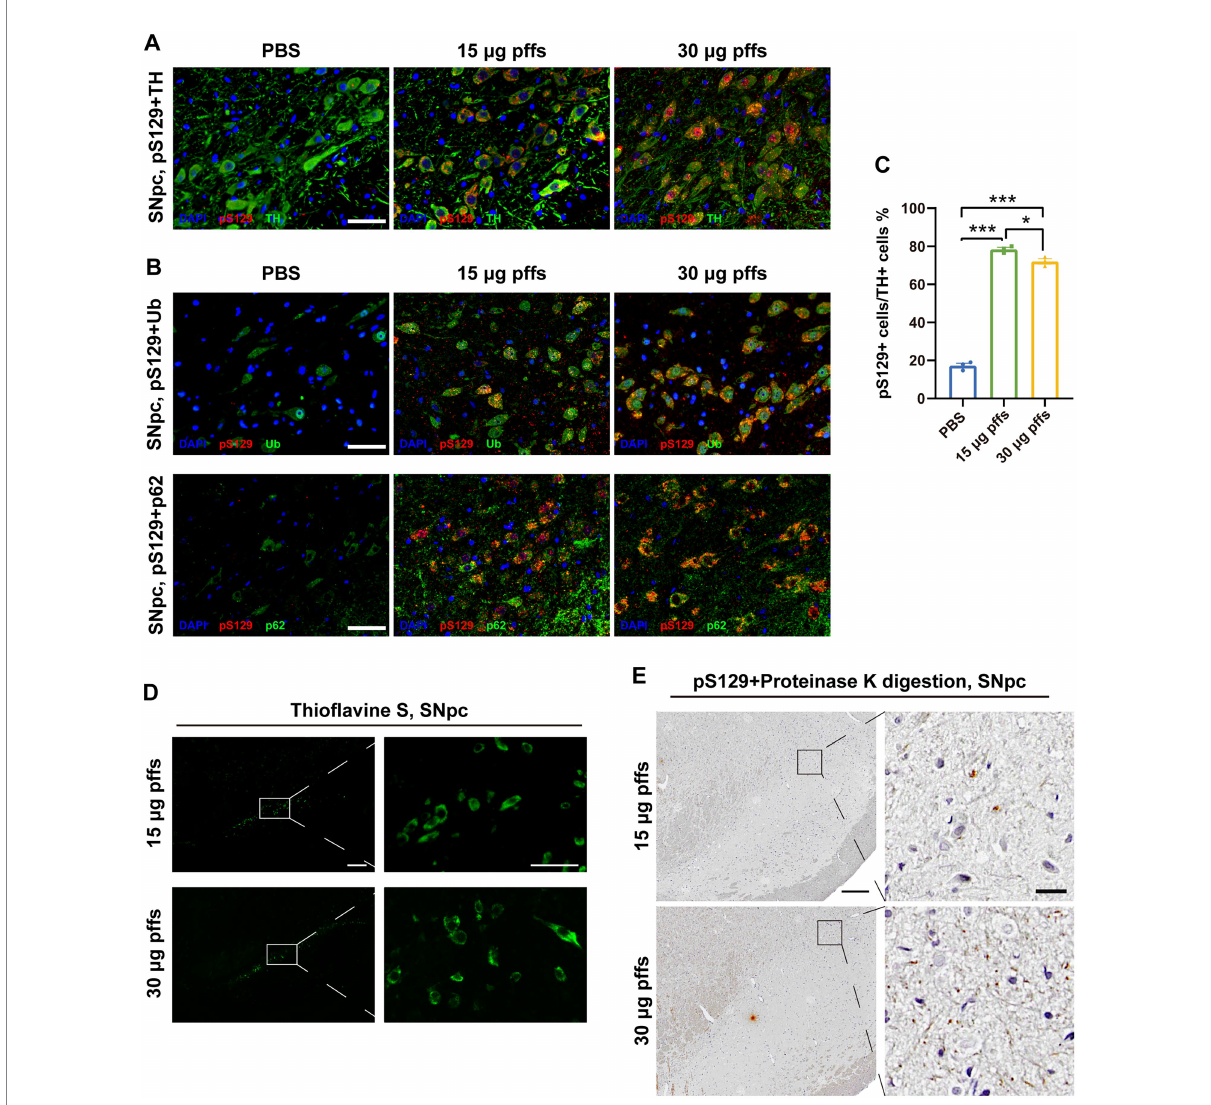
FIGURE 3 Intrastriatal injection of α -SynN103/tauN368 PFFs complex initiated α -synucleinopathy with common characteristics as human conditions in rats. (A) α -Syn pathology was detected in the ipsilateral SNpc. Scale bar = 50 μ m. (B) α -Syn aggregates in the section of SNpc were confirmed by anti- α - Syn pS129, anti-p62 and anti-ubiquitin immunofluorescent staining. Scale bar = 50 μ m. (C) α -Syn pS129-positive cells in the SNpc were quantified by counting ( n = 3; * p < 0.05, *** p < 0.001). (D) Inclusions in the PFFs model were stained with thioflavin-S. High magnification images of boxed area showed on the right. Scale bar = 200 μ m (left) and 50 μ m (right). (E) Inclusions in the PFFs model were proteinase K resistant. High magnification images of boxed area were on the right. Scale bar = 200 μ m (left) and 20 μ m (right). All of the data was shown as means ±